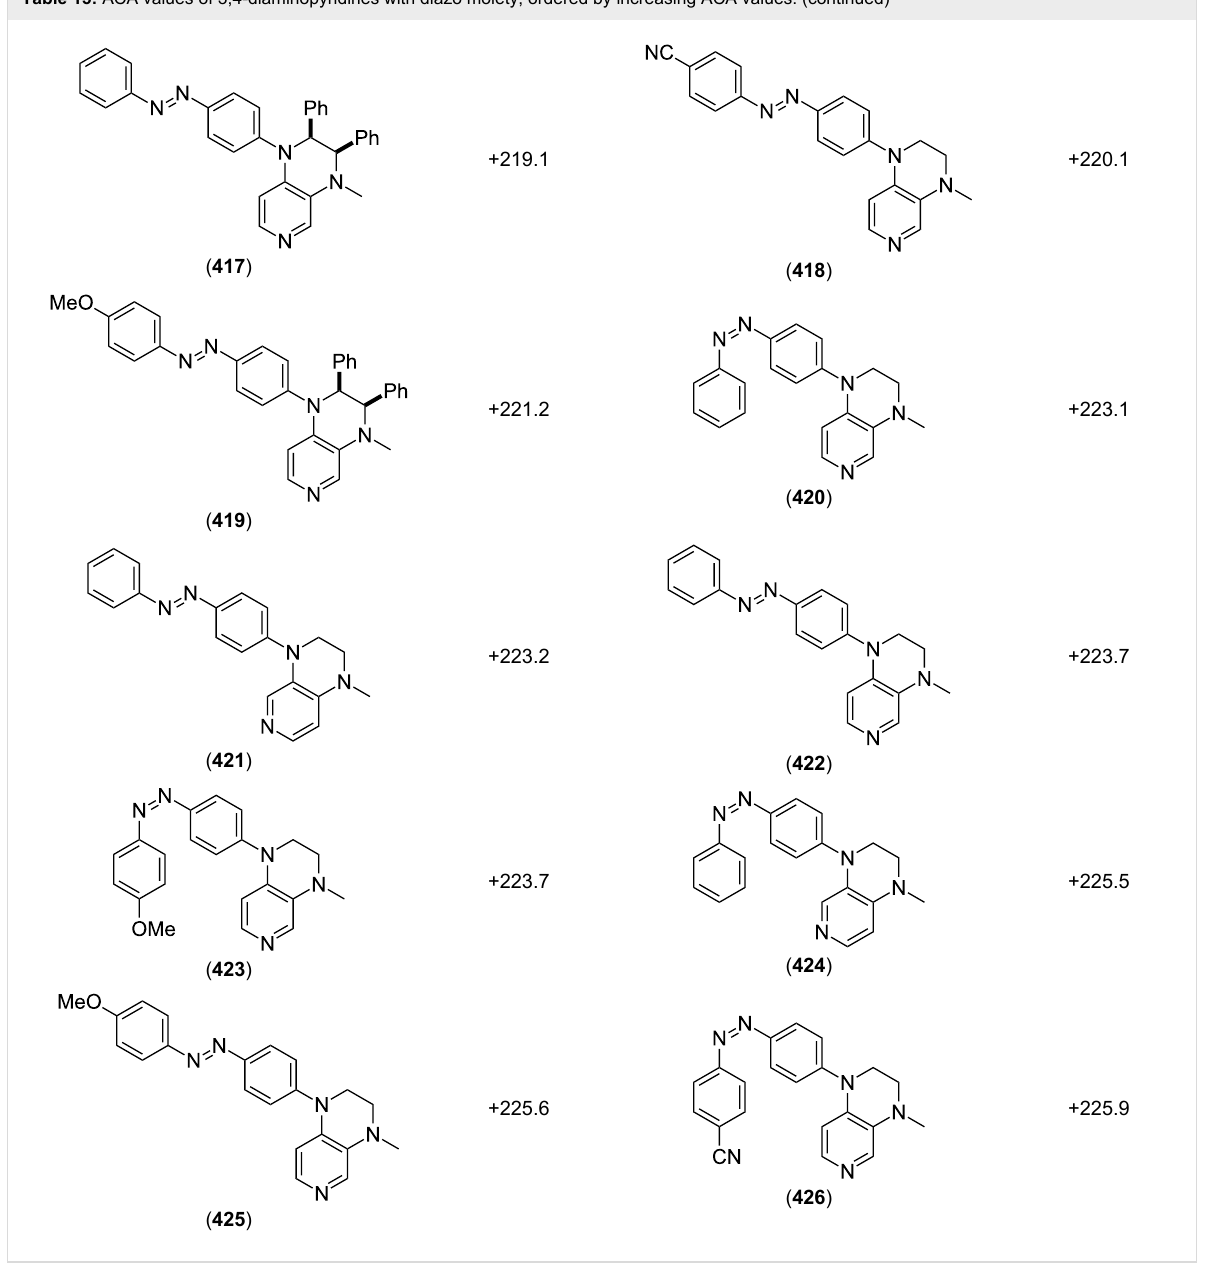
Table 15: ACA values of 3,4-diaminopyridines with diazo moiety, ordered by increasing ACA values.